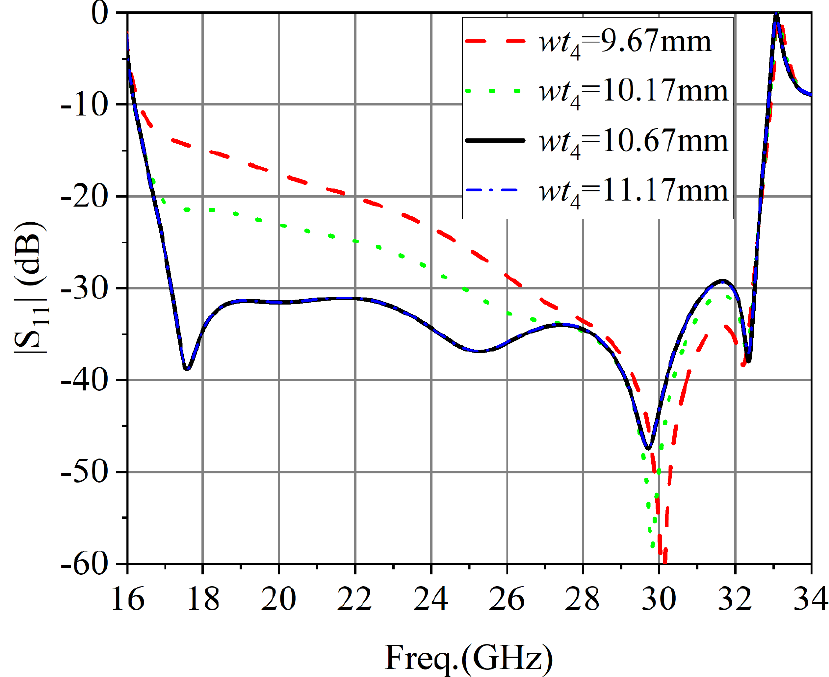
Figure 11. The simulated results of the second stage metal step width.